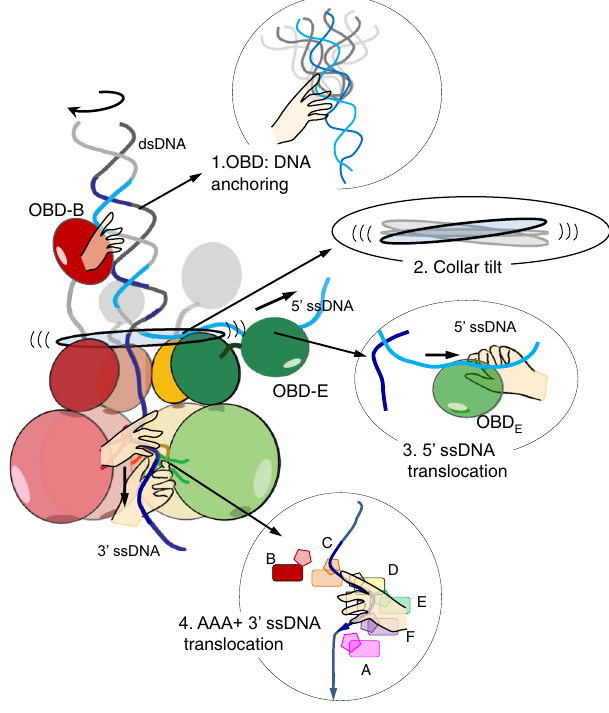
Fig. 8 Cartoon model for E1 DNA unwinding. Each arm of the RF DNA associates with speci fi c protein segments indicated with the hands. OBD B tracks the major groove of the inbound, rotating, dsDNA while additional OBDs surround it, stabilising its position above the collar domain. OBD E and residues in the E1HD domain (Asn352) and inter-domain linker (Lys310) chaperone the 5 ′ ssDNA away from the unwinding point (see Fig. 5). Unwinding is driven by ATP hydrolysis in the AAA + domain linked to translocation of the 3 ′ ssDNA. Strand separation could be assisted by a once-per-revolution power-stroke of the collar domain, directly coupled to the ATP ase